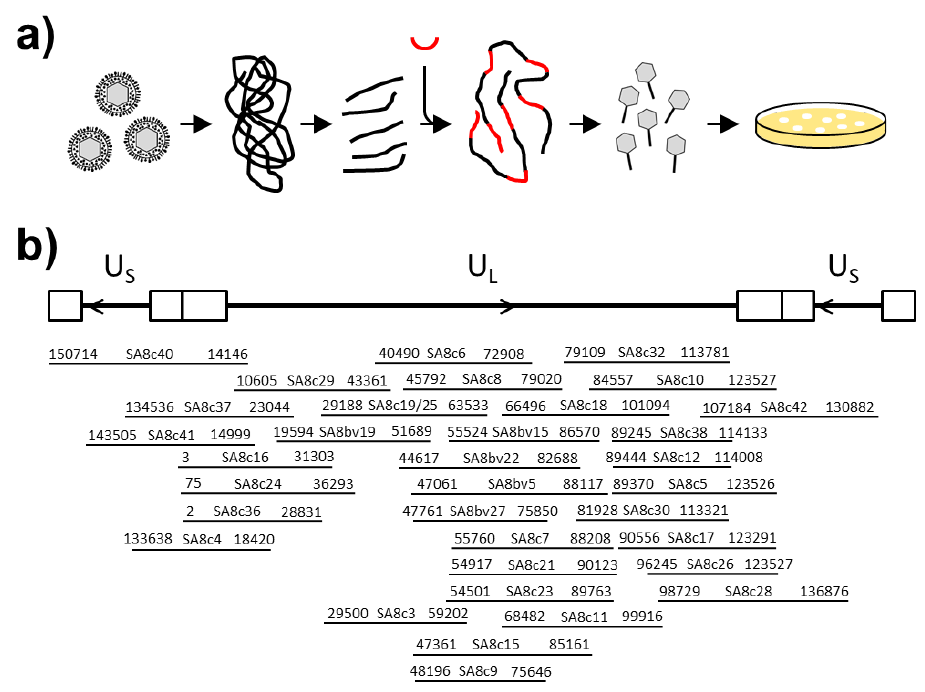
Figure 1. Cloning and characterization of CeHV-2 fosmids. ( a ) Scheme of CeHV-2 genome cloning. Viral DNA was isolated from virus particles, sheared, end-repaired and size fractionated on an agarose gel. Fractionated fragments were ligated into fosmid vector pCC1FOS (red) and packaged into phage lambda particles, which were then used to transduce cells of E. coli strain EPI300. Individual colonies were further characterized by colony PCR, end-sequencing, and restriction digest. ( b ) An overview of all fosmid clones that are characterized by colony PCR and end-sequencing. The genome of CeHV-2 is schematically represented on top, with U S regions drawn on both sides of the U L region. The direction of gene order, in the U L and U S regions, is indicated by arrows and inverted repeats are drawn as boxes. The positions of fosmid inserts are drawn as lines. The names of the fosmids and nucleotide positions of the insertions are given above the respective lines.